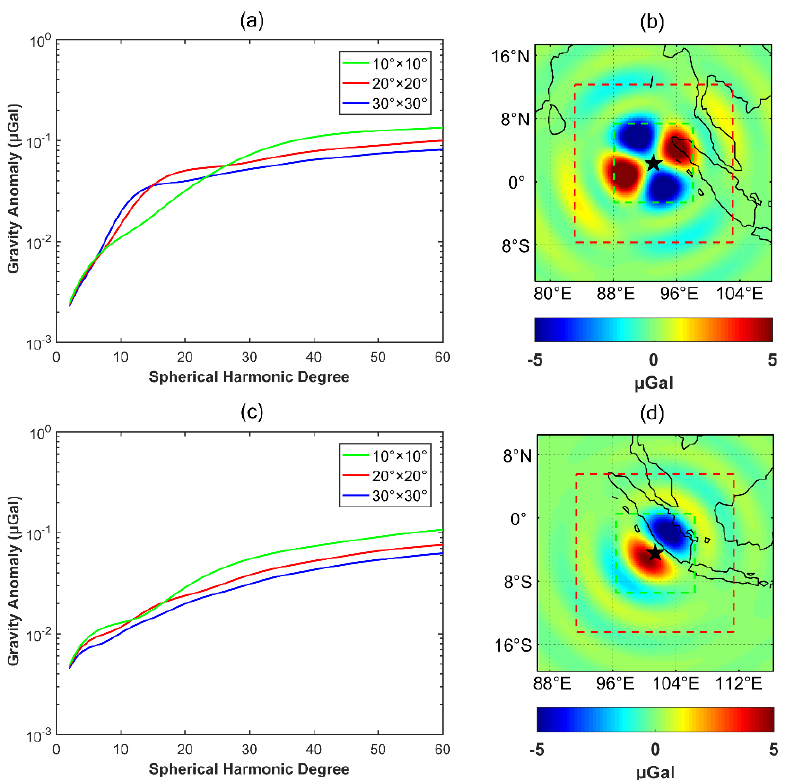
Figure 12. Model predictions of coseismic gravity change in spectral domain and spatial domain for different region ranges. ( a , b ) are the 2012 Mw8.6 Indian Ocean coseismic gravity change in spectral and spatial domain, respectively. ( c , d ) correspond to 2007 Mw8.4 Bengkulu event. The green line is 10° × 10° region and red line is 20° × 20° region.